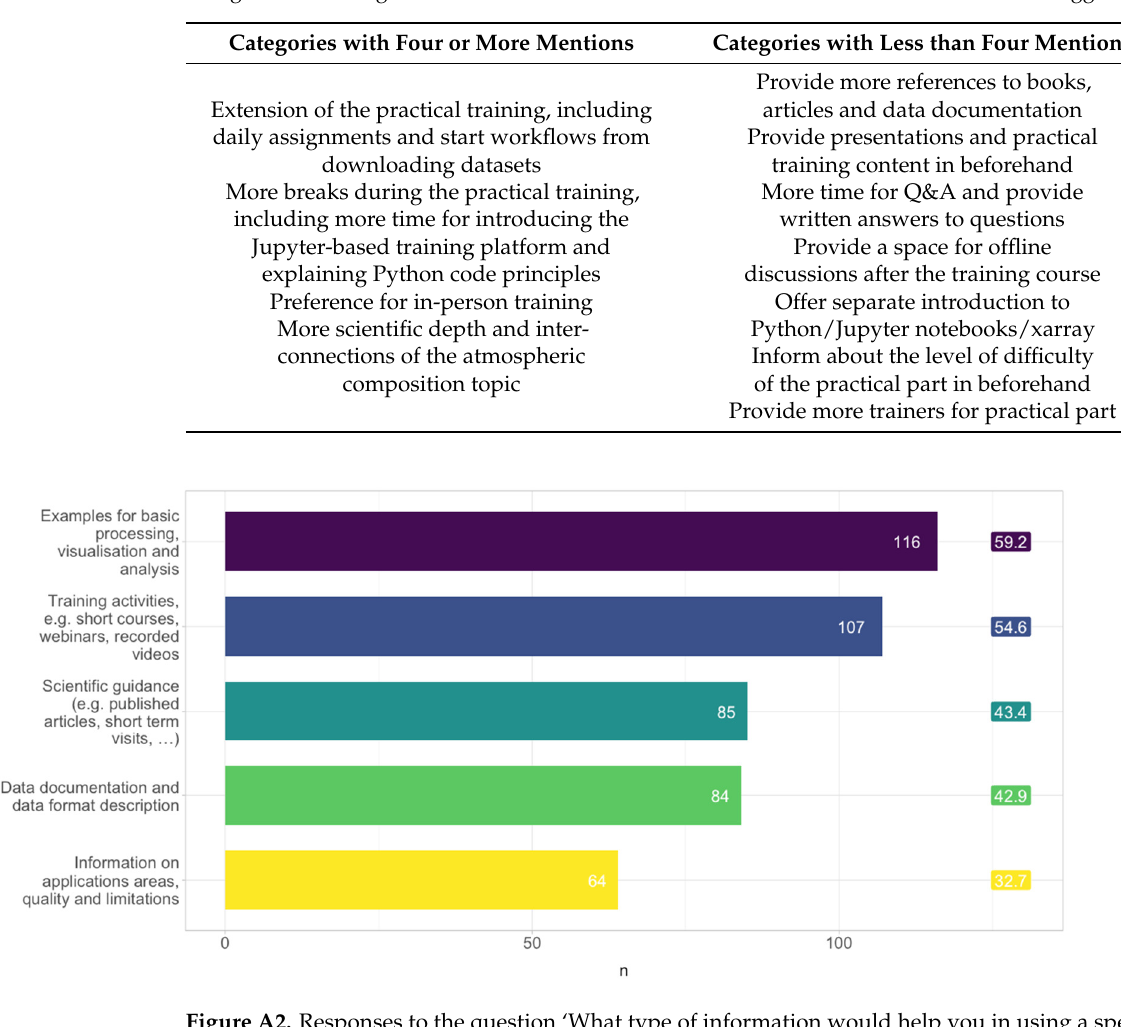
Table A4. Categories of responses to the question ‘What should we do differently next time?’ ( n = 92). Categories on the left have four or more mentions, with the first category (Extension of practical training part) being by far the most mentioned suggestion ( n = 27). Others had four or five mentions. Categories on the right were mentioned less than four times but are considered as useful suggestions.